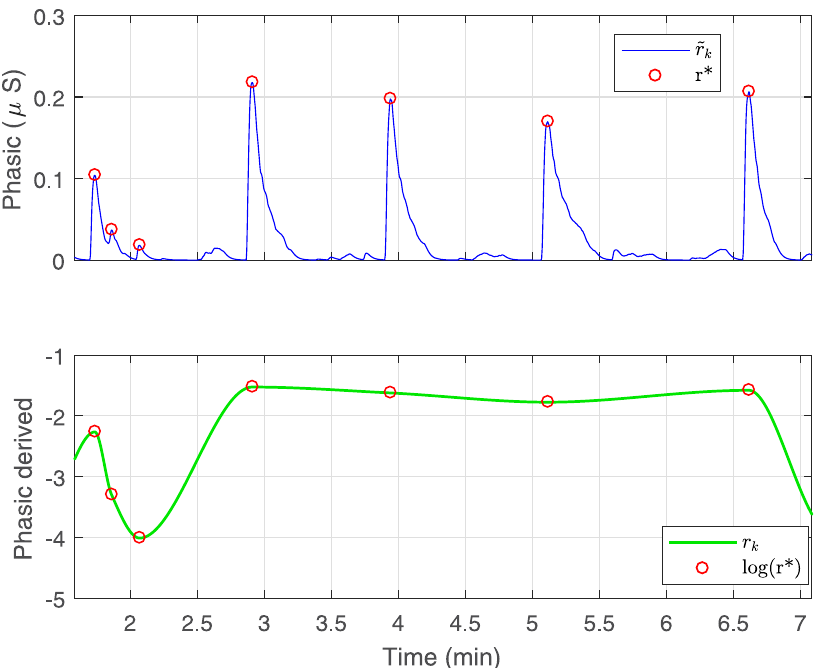
Fig 3. Extraction of the phasic-derived component r k from ~ r . The amplitudes of each of the SCRs are related to k sympathetic arousal. Therefore, we derive an artificial phasic-related component by detecting peaks and then interpolating over the log values of the peak amplitudes. The figure shows a zoomed-in section illustrating the derivation.